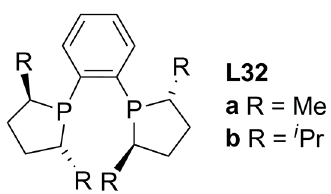
Figure 13. DuPHOS